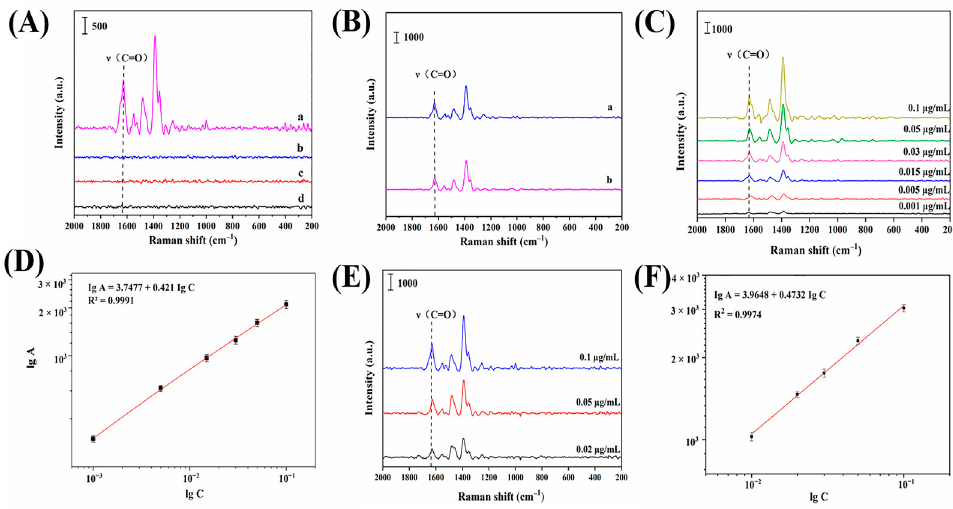
Figure 5. ( A ) SERS spectra of Ag NPs–MIPs film adsorption of 1.0 μ g/mL ENRO (a), SERS spectra of Ag NPs–MIPs film adsorption of 1.0 μ g/mL ciprofloxacin (b), SERS spectra of Ag NPs–MIPs film adsorption of 1.0 μ g/mL moxifloxacin (c), and SERS spectra of Ag NPs–MIPs film adsorption of 1.0 μ g/mL norfloxacin (d). ( B ) SERS spectra of Ag NPs–MIPs film for 1.0 μ g/mL ENRO (a), SERS spectra of Ag NPs–MIPs film for 1.0 μ g/mL mixed solution containing ENRO, ciprofloxacin, moxifloxacin, and norfloxacin. ( C ) SERS spectra of Ag NPs–MIPs film detection of standard solutions of different concentrations of ENRO. ( D ) Calibration curves of Ag NPs–MIPs film detection of ENRO solutions. ( E ) SERS spectra of Ag NPs–MIPs film adsorption spiked with ENRO pork. ( F ) Calibration curve of ENRO detection by HPLC. Table 1. Comparison of various methods for the detection of residual enrofloxacin. Response Range Methodology Fluorescent carbon dots Terbium-sensitized fluorescence Voltammetry